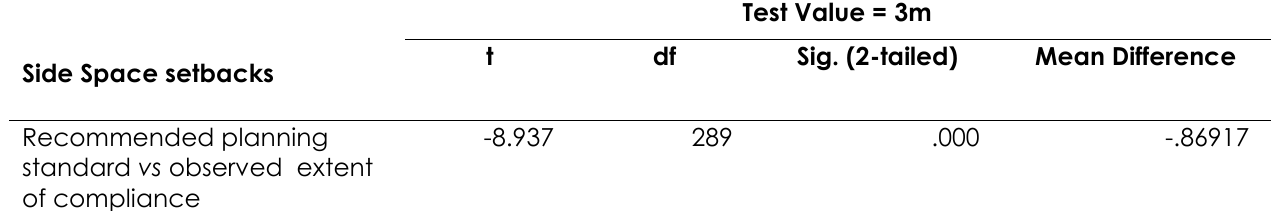
Table 7: Significance test for the second hypothesis